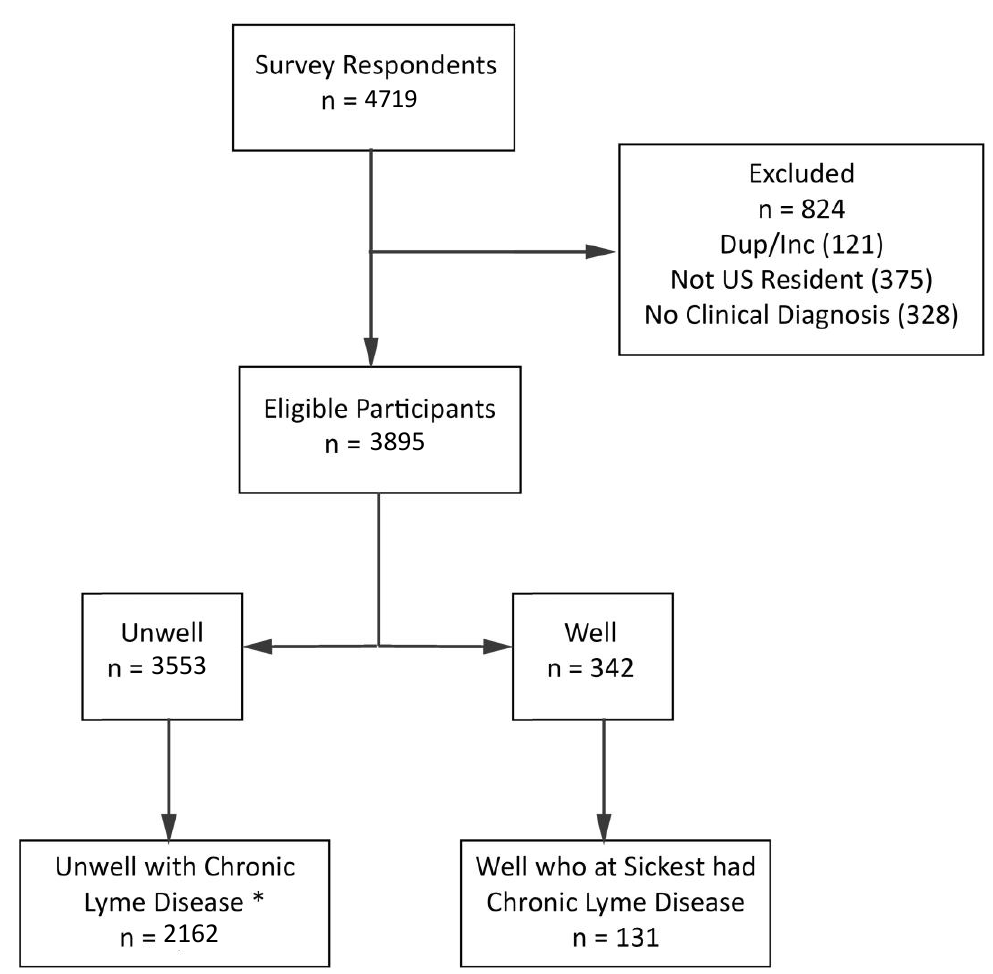
Figure 1. Preliminary sample, exclusions, and final sample size determination. * Chronic Lyme disease participants consist of patients with Lyme Disease who remained ill for at least 6 months following a short-term course of antibiotics. Unwell sample excludes 10 participants who skipped GROC question regarding treatment